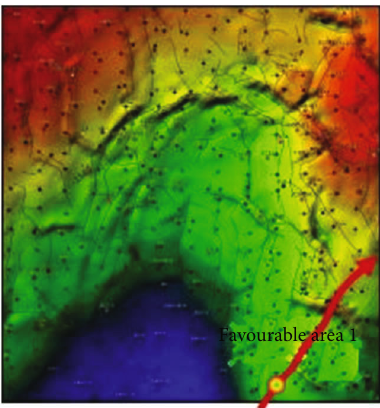
Figure 9: Favorable area 1 migration trend controlled by